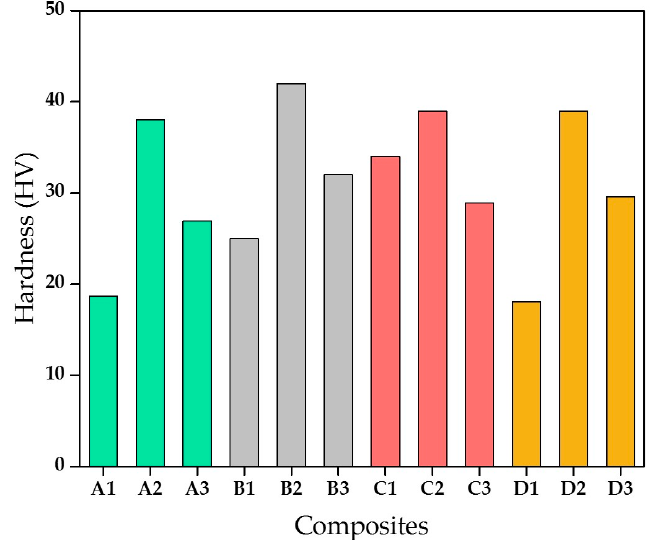
Figure 4. Hardness behaviour of composites.